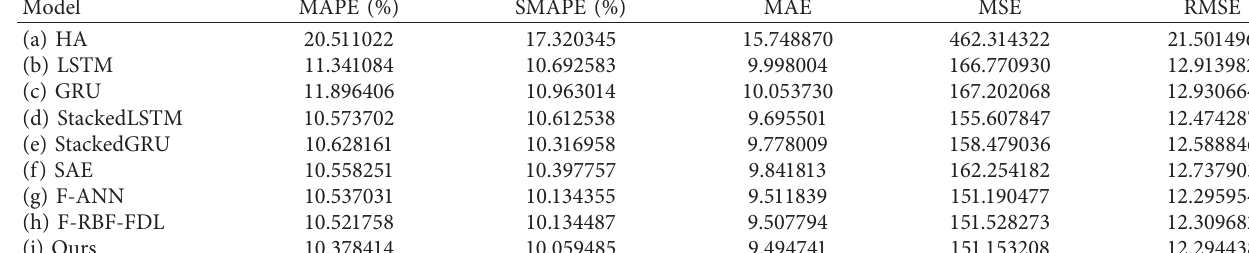
Table 5: Performance comparison of the proposed one and